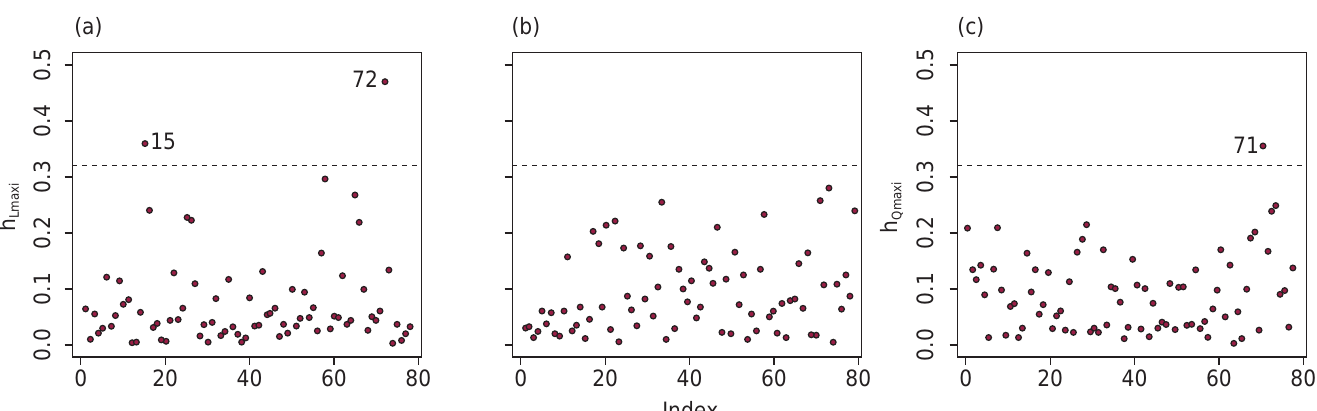
Figure 2. Graphs of local influence perturbing the response variable considering: (a) the Gaussian spatial linear model (GSLM) and measure | h [ L ] max |; (b) the slash spatial linear model (SSLM) and measure | h [ L ] max |; and (c) the slash spatial linear model (SSLM) and measure | h [ Q ] max |. Observations above the dotted line are classified as